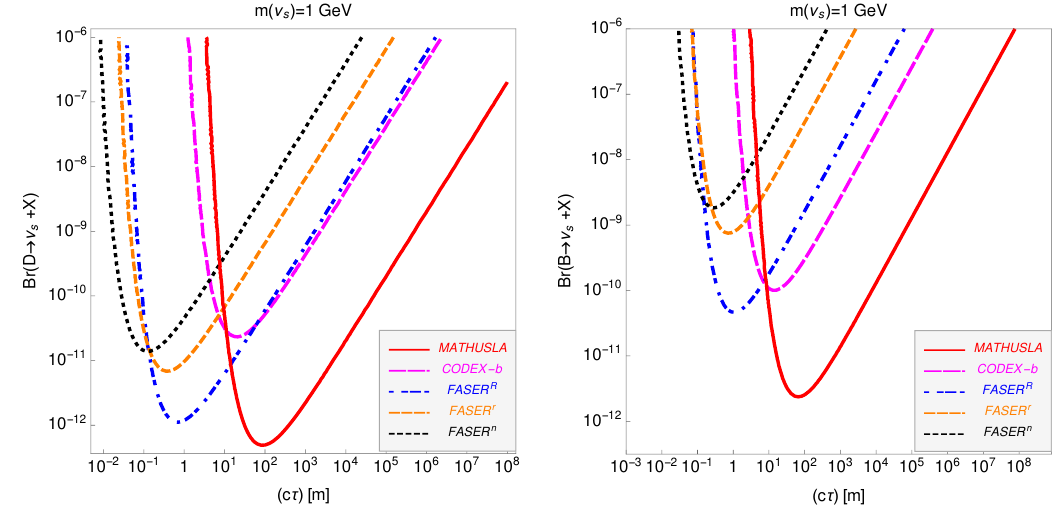
Figure 1 . Sensitivity estimates in the plane branching ratio versus decay length ( c(cid:28) ) for CODEX- b, FASER and MATHUSLA. The plot to the left is for neutral fermions from D-meson decays, to the right the corresponding results for B-mesons. Here and in all other sensitivity plots we use the contours of 4 signal events to estimate the sensitivity